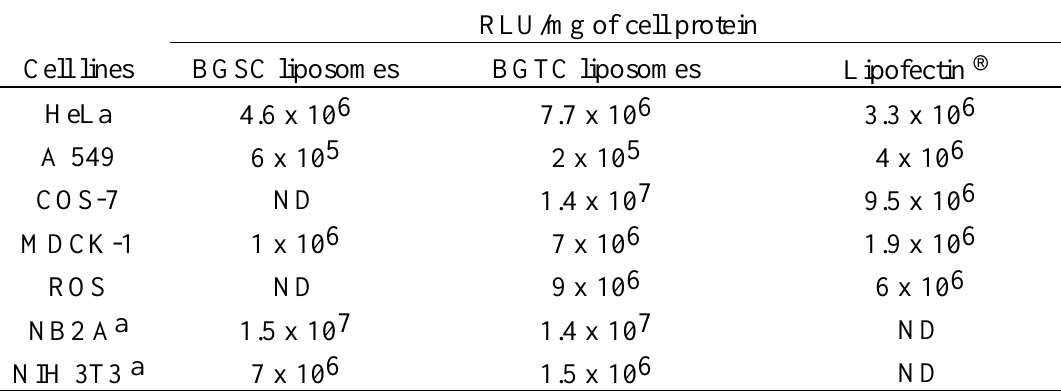
Table 2. Luciferase expression in various eukaryotic cell lines transfected by BGSC/DOPE liposomes, by BGTC/DOPE liposomes and by Lipofectin®